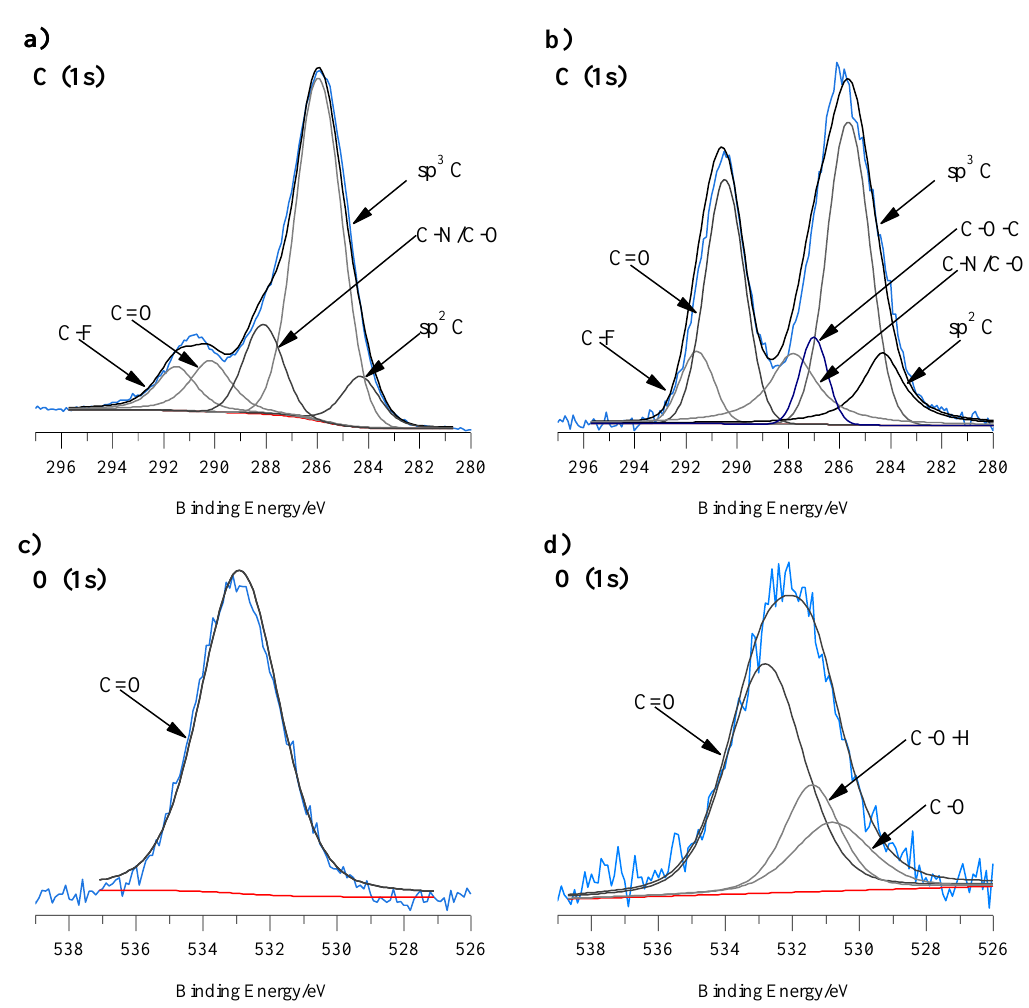
Figure 3. High-resolution XPS spectra of C(1s) and O(1s) recorded for non-conditioned membrane ( a,c ) and membrane conditioned in 0.1 mol L −1 NaHCO 3 ( b,d ).